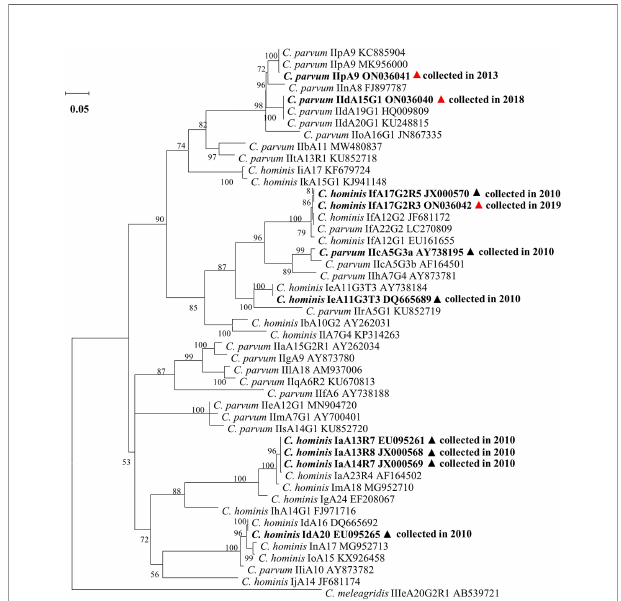
FIGURE 2 | Phylogenetic relationship of Cryptosporidium hominis and Cryptosporidium parvum subtypes based on a maximum likelihood (ML) analysis of sequences of the 60 kDa glycoprotein gene from collected samples and compared to the GenBank reference gene, with bootstrap values above 50% being shown on nodes. Isolates from this study are in bold and labeled with red triangles, while isolates from the study conducted in 2010 are in bold and labeled with black triangles. In this study, all samples used in the analysis are from monkey feces.